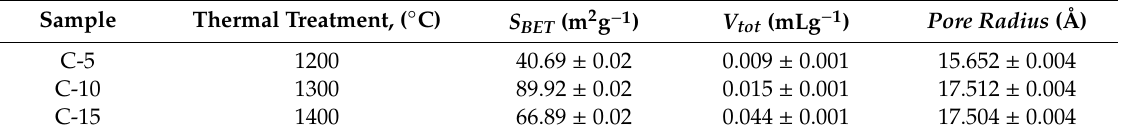
Table 3. Results of nitrogen sorption isotherms of carbonized metallic polymer